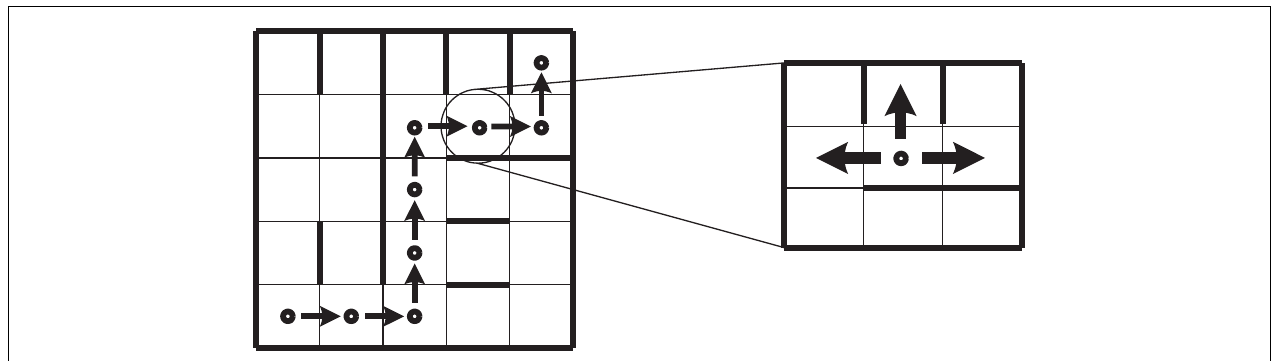
FIGURE 1 | Representation of an agent in a grid that must move from s 0 to s f . The shortest path is shown (left). At every step, there exist one correct and one wrong choice and the option to move back to the previous state (right).